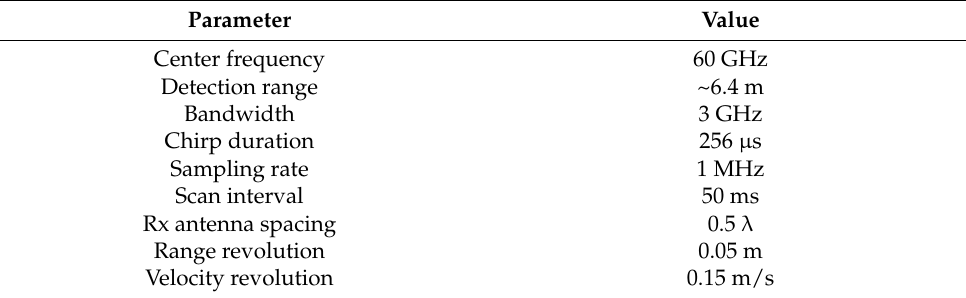
Table 1. Radar parameters and specifications.